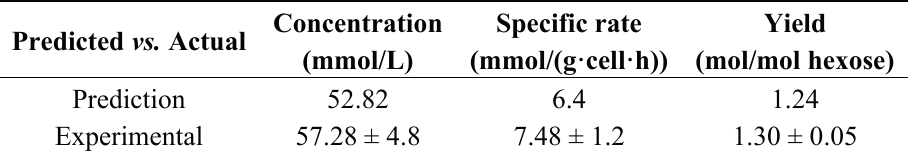
Table 8. Verification of the overall optimum composition (OptH) for H 2